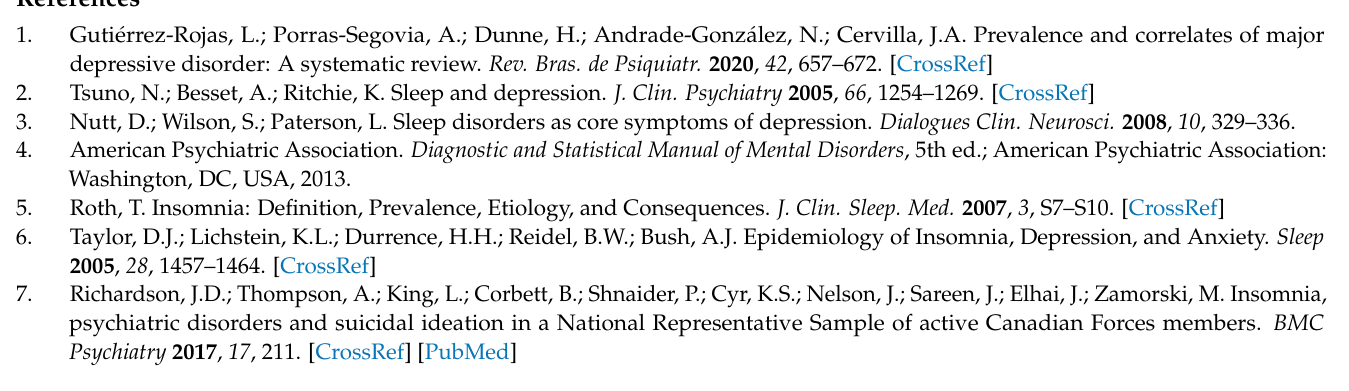
sis, Figure S4: Functional consequences of SNPs on genes in positional mapping, Supplementary Table S1: Summary of the datasets used in this study; Supplementary Table S2: Lead SNP results from meta-analysis; Supplementary Table S3: Results from tissue expression analysis; Supplemen- tary Table S4: Results from cell type specificity analysis in the mouse cerebellum; Supplementary Table S5: Results from cell type specificity analysis in the mouse frontal cortex; Supplementary Table S6: Results from cell type specificity analysis in the human cortex; Supplementary Table S7: Re- sults from positional mapping; Supplementary Table S8: Results from eQTL mapping (54 tissue types); Supplementary Table S9: Results from eQTL mapping (13 brain regions); Supplementary Table S10: Gene set analysis results from positional mapping; Supplementary Table S11: Gene set analysis results from eQTL mapping (54 tissue types); Supplementary Table S12: Gene set analysis re- sults from eQTL mapping (13 brain regions); Supplementary Table S13: Protein connectivity ranking and the drug-gene interaction results; Supplementary Table S14: Approved shared drugs for MDD and